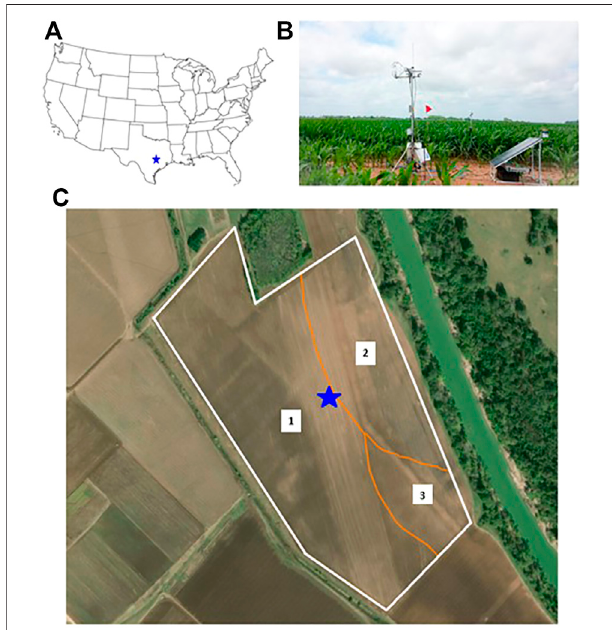
FIGURE 1 | (A) Location of the study fi eld near College Station, Texas, United States; (B) Eddy covariance fl ux tower in the fi eld; (C) High-resolution PlanetScope satellite image of the study fi eld with the white outline indicating the boundary and the yellowstar indicatingthe location ofthe fl ux tower. Numbers1 – 3represent soiltypes presentat the siteand orange lines indicate the boundary between soil types.